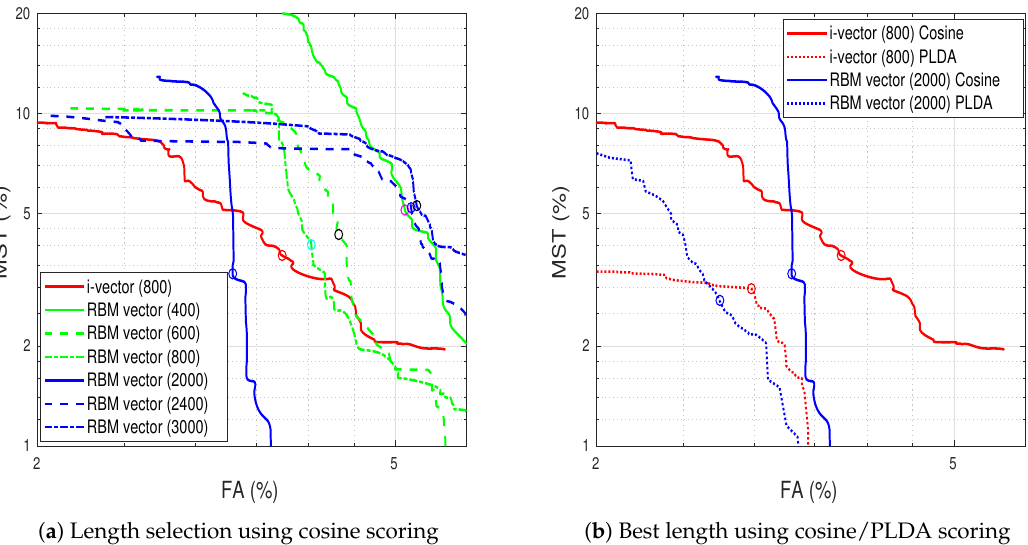
Figure 6. Comparison of Detection Error Trade-off (DET) curves for the proposed RBM vectors with 800 dimensional i-vectors. Different lengths of RBM vectors are evaluated using cosine and PLDA scoring. The lengths of RBM vectors and i-vectors are given in